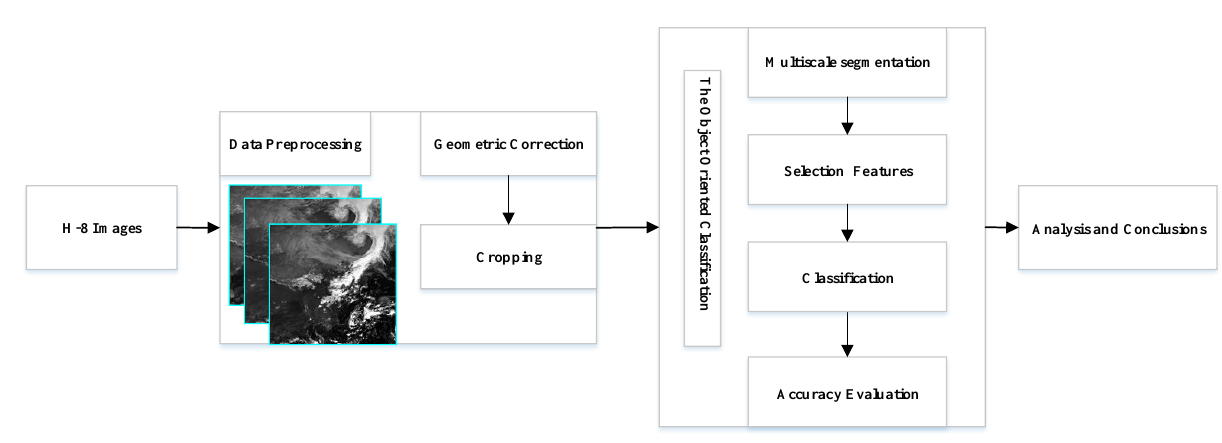
Figure 3 . Flow chart of object-oriented classification